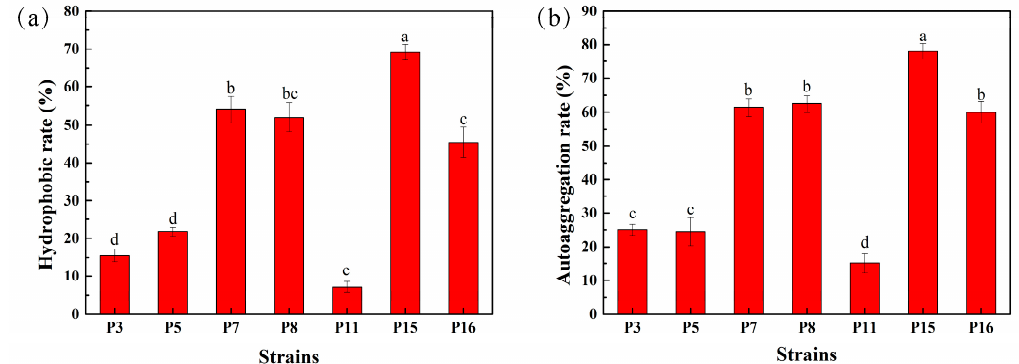
Figure 2. Cell surface hydrophobicity and auto-aggregation ability of representative LAB isolates. ( a ) Hydrophobicity (%), ( b ) auto-aggregation (%). Different lowercase letters (a, b, c, d, e,) denote significant differences ( p < 0.05), and results were expressed as mean ± standard deviation (SD) ( n = 3).